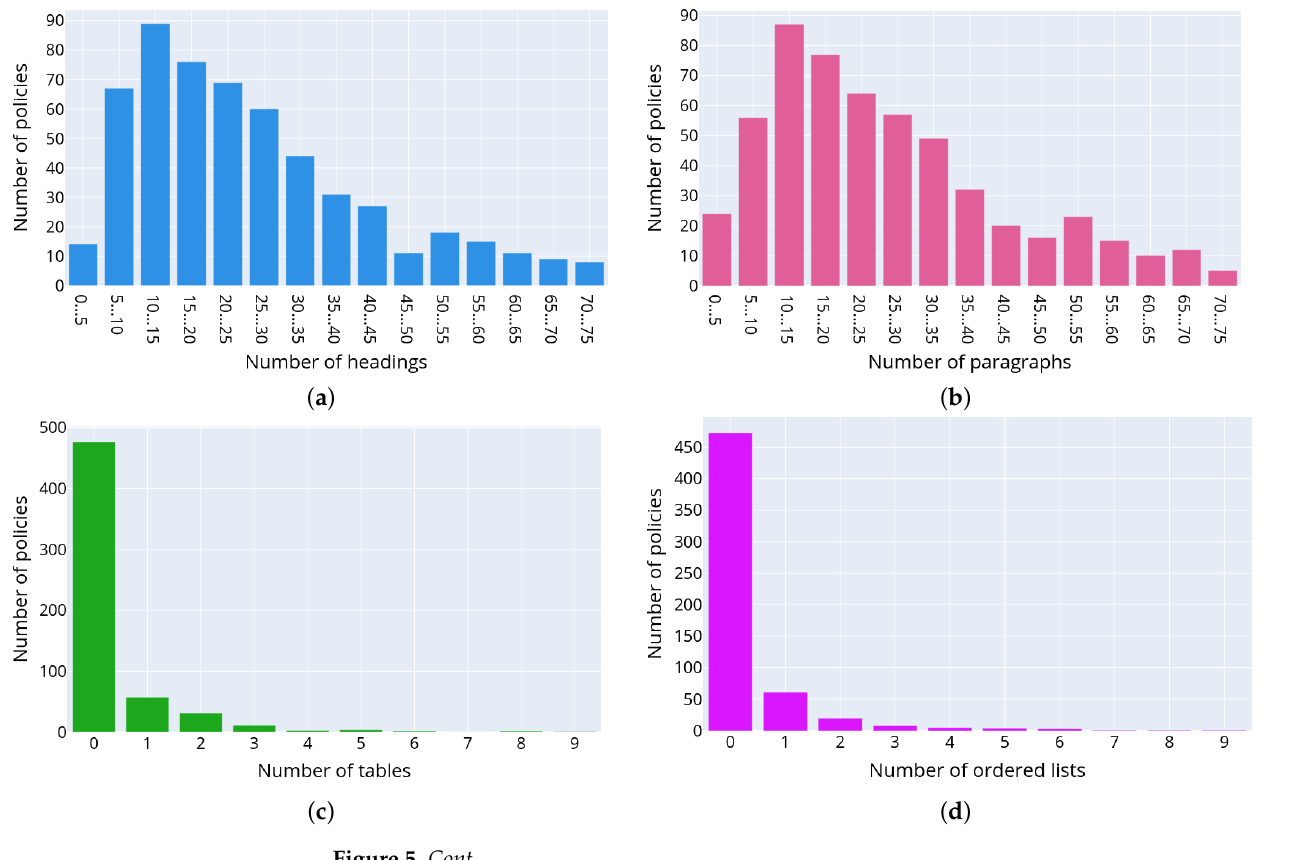
Figure 4. Characteristics of privacy policies of the corpus: ( a ) distribution of the text structural elements in the text of privacy policy; ( b ) number of the text structural elements in the text of average privacy policy.